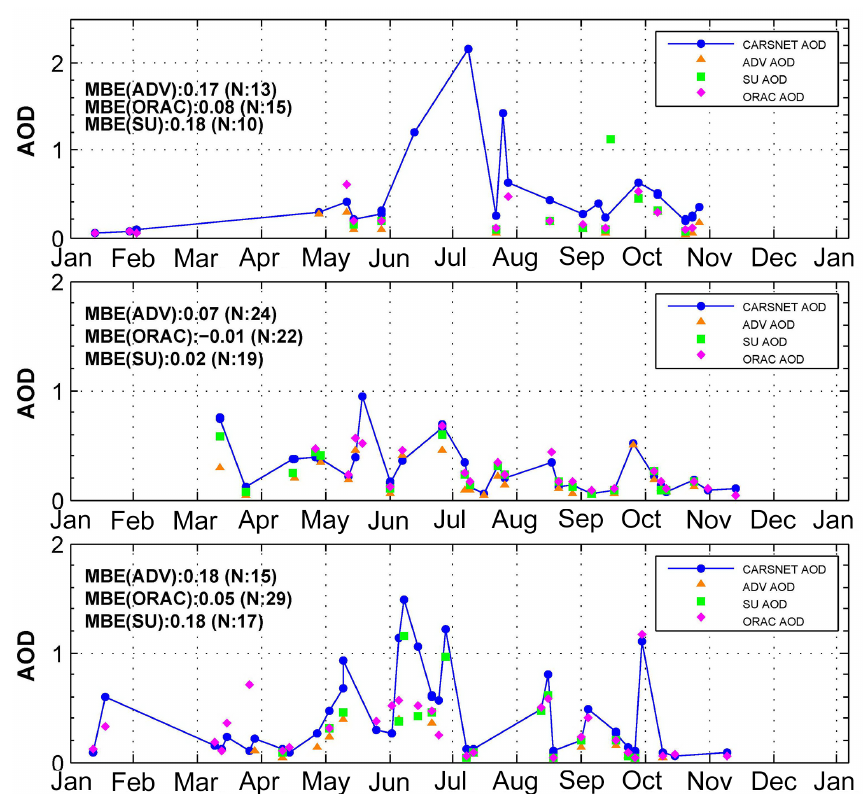
Figure 7. Time series comparison of AATSR AOD with CARSNET AOD at Shangdianzi in 2007, 2008, and 2010. Table 8. Seasonal distribution of validation results of three